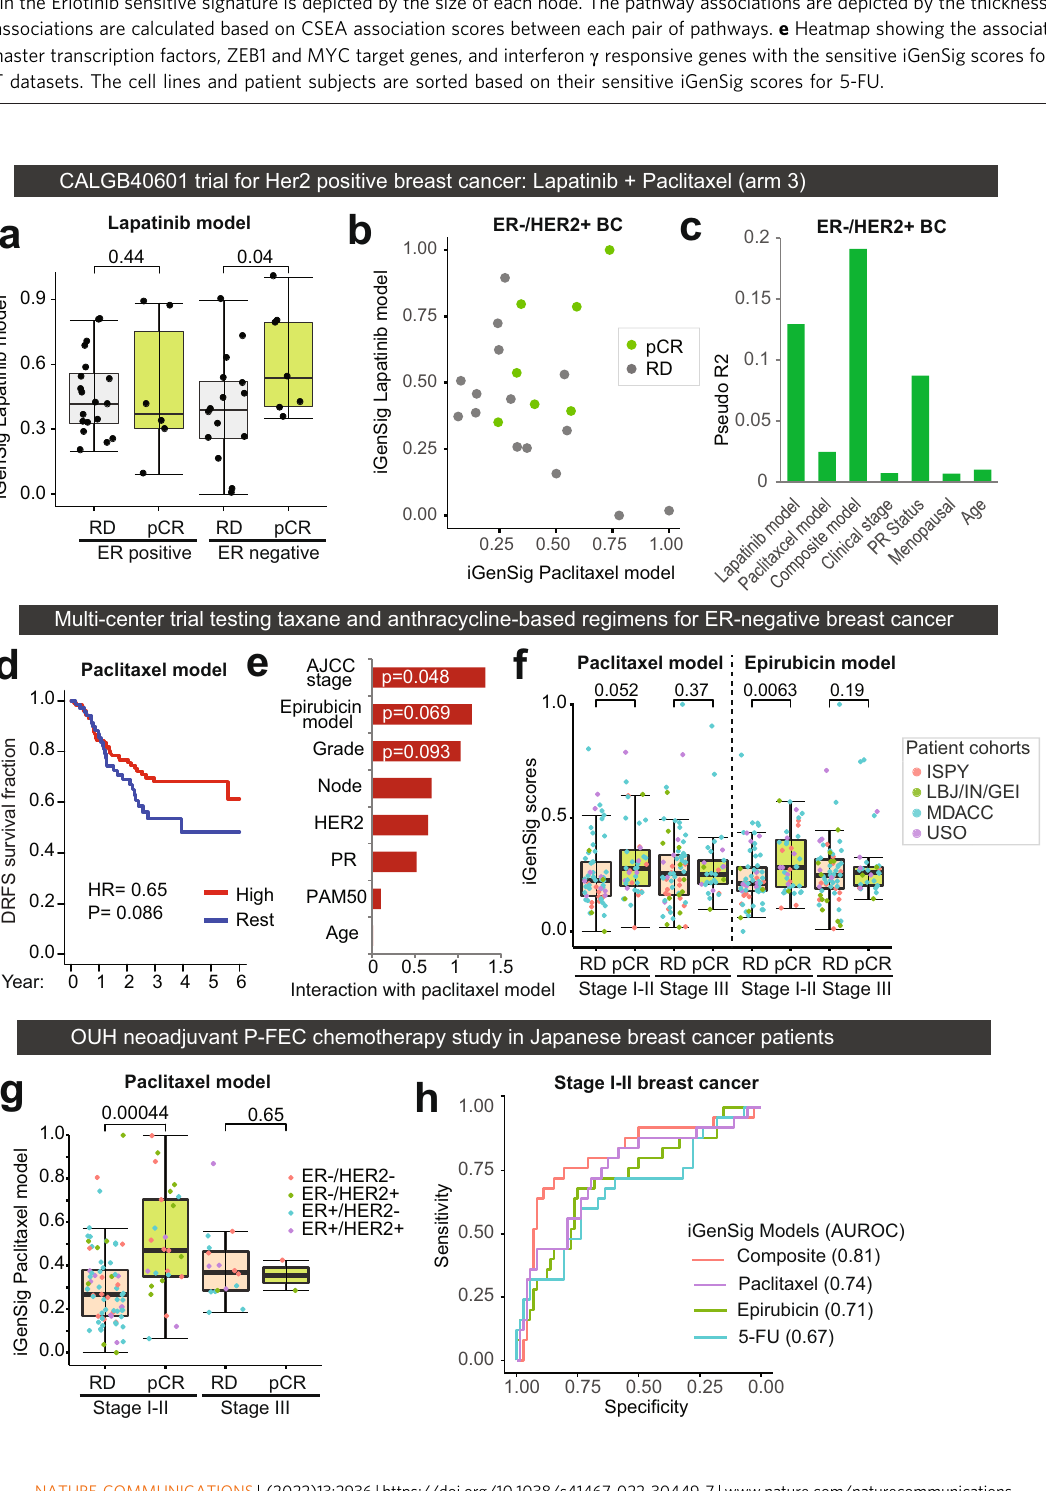
Fig. 5 Predictive values of the iGenSig model for 5-FU developed from GDSC cell line pharmacogenomic dataset on patient survival in the French CIT multicenter postsurgical colon cancer patient cohort. a Kaplan – Meier plot showing the predictive values of the GDSC iGenSig model for 5-FU on the overall survival of patients from the French CIT cohort treated with 5-FU monotherapy. A data-driven cut point of high iGenSig scores was determined as described in Methods and the P value is calculated based on the log-rank test. b The predictive values of the GDSC iGenSig model for 5-FU on the overall survival of all patient subjects from the CIT cohort treated with different adjuvant chemotherapy regimens or untreated. The BRAF and KRAS mutation status for each subject are indicated by colored dots. The boxplot elements indicate the maxima, 75th percentile, median, 25th percentile, and minima. The p values are based on one-sided student ’ s t -tests. c The predictive values of the GDSC iGenSig models for irinotecan and 5-FU on the patient subjects treated with the FOLFIRI regimen in the CIT study. The patients are strati fi ed based on their overall survival and their sensitive iGenSig scores based on the two models are plotted. d The network of upregulated and downregulated pathways characteristic of 5-FU sensitive GDSC cell line subjects. The top upregulated and downregulated pathways clustered in the respective interconnected networks are shown in the fi gure. The CSEA enrichment score for each pathway in the Erlotinib sensitive signature is depicted by the size of each node. The pathway associations are depicted by the thickness of the edge. The pathway associations are calculated based on CSEA association scores between each pair of pathways. e Heatmap showing the associations of EMT markers and master transcription factors, ZEB1 and MYC target genes, and interferon γ responsive genes with the sensitive iGenSig scores for 5-FU in the GDSC and CIT datasets. The cell lines and patient subjects are sorted based on their sensitive iGenSig scores for 5-FU.